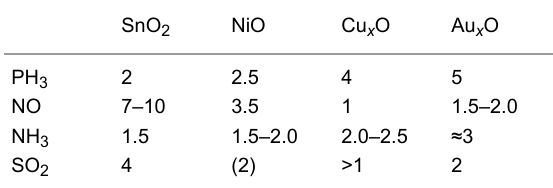
form alternate extrinsic semiconductors, which can be of p , p +